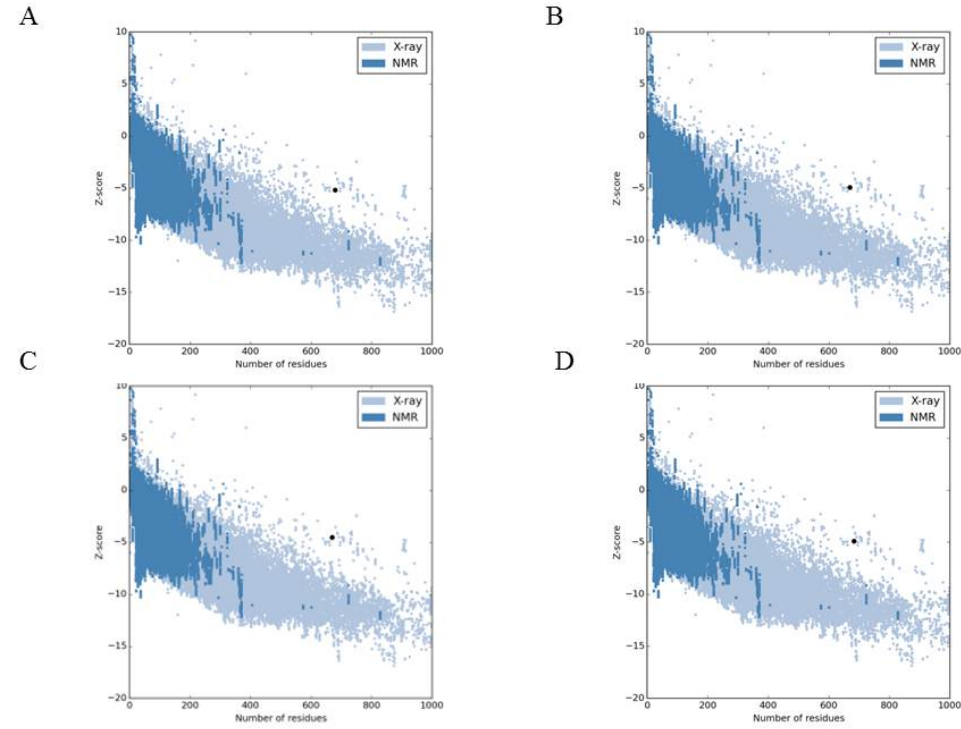
Figure 3. Overall model quality of predicted protein models by ProSA. ( A ) CAM07737. ( B )